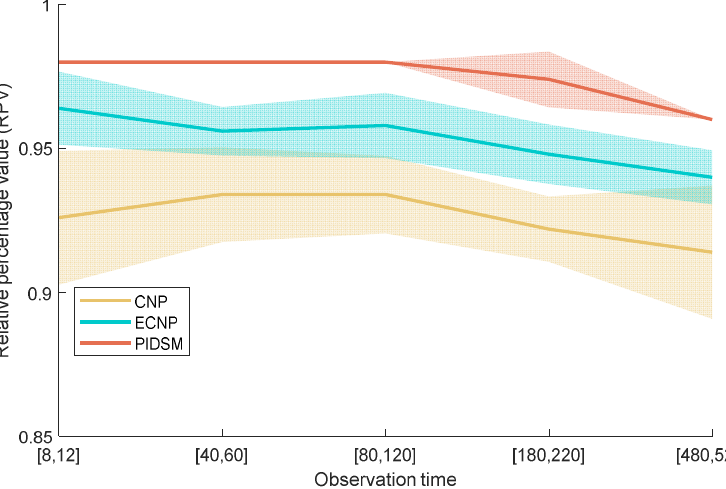
Figure 9. The impact of the variation of target observation time on the performance of the algo- rithms.